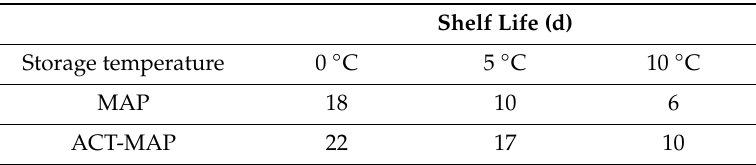
Table 3. Shelf life of MAP and ACT-MAP gutted sea bass during the isothermal storage at 0 ◦ C, 5 ◦ C, and 10 ◦ C by using the developed mathematical model (limit for shelf life estimation = 10 7 CFU g − 1 for the total viable